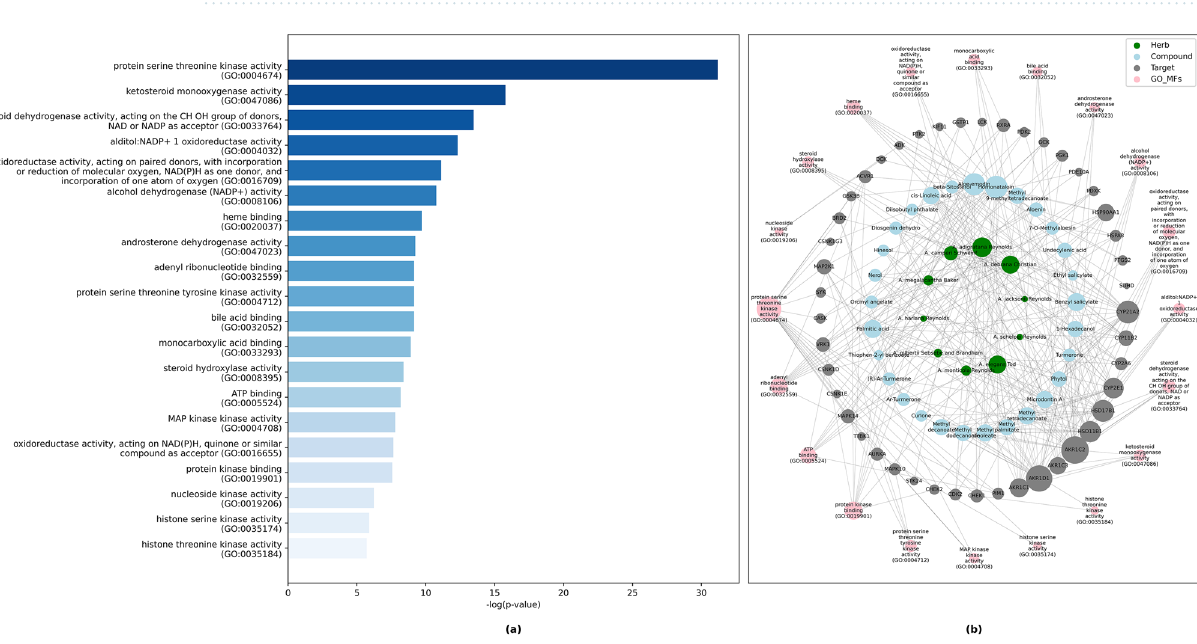
Figure 3. ( a ) Bar graph of KEGG analysis for top 20 enriched molecular functions. ( b ) Phytochemical-target- molecular function network constructed by python NetworkX library illustrated pathways and their associated genes (Adjusted P ≤